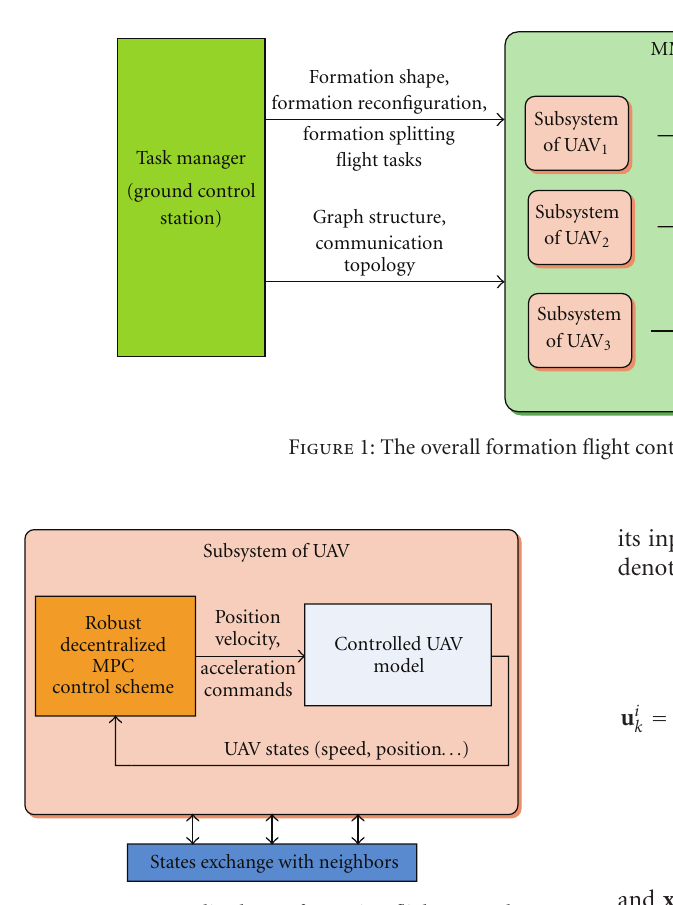
Figure 2: Decentralized UAV formation flight control.